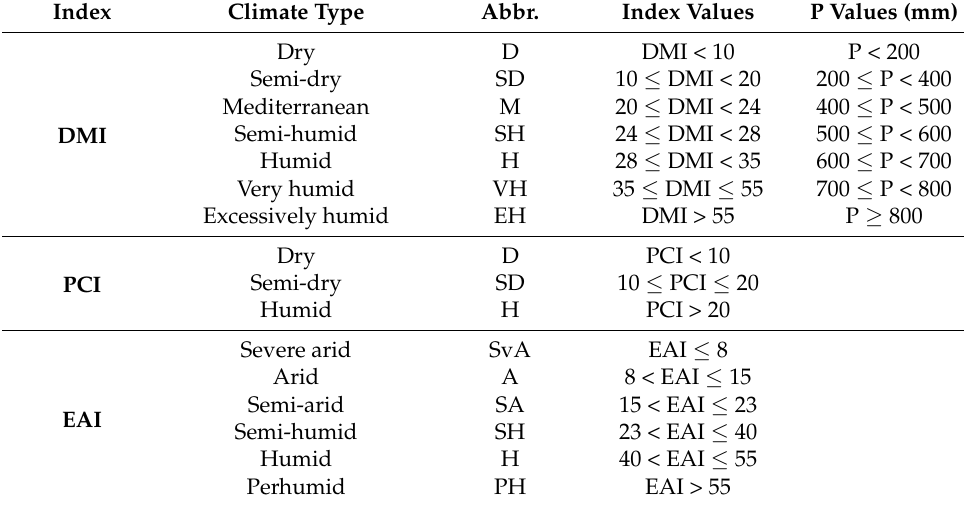
Table 2. Climatic classification for the De Martonne Aridity Index (DMI), the Pinna Combinative Index (PCI), and the Erinç Aridity Index